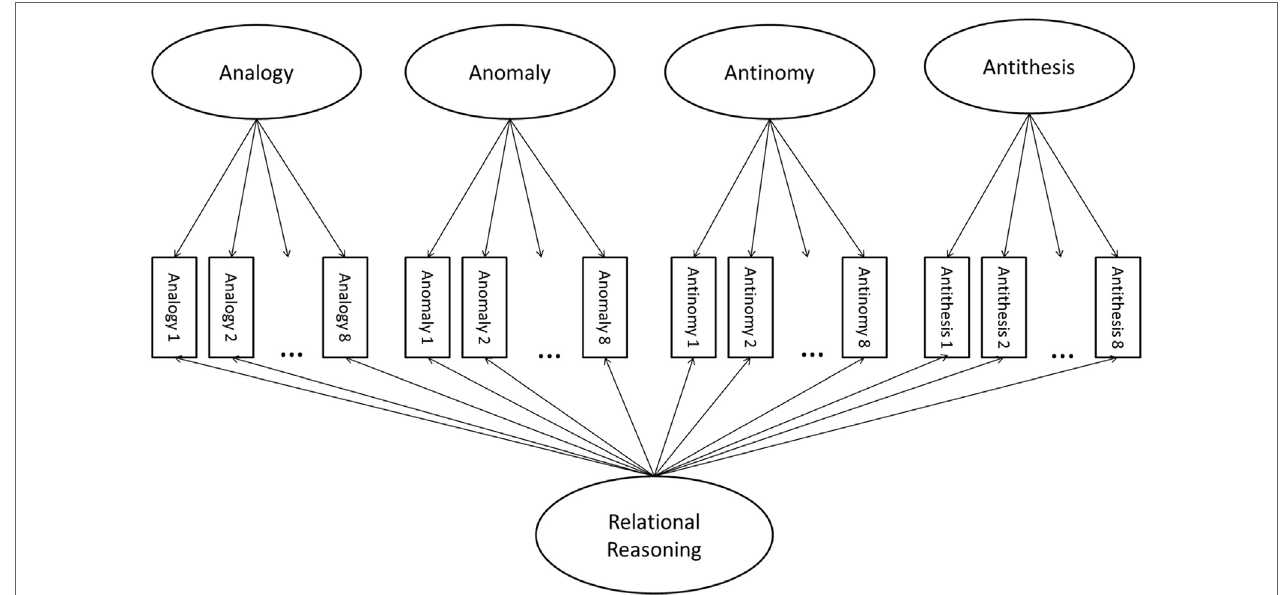
FiGurE 1 | A conceptual path diagram of the bifactor